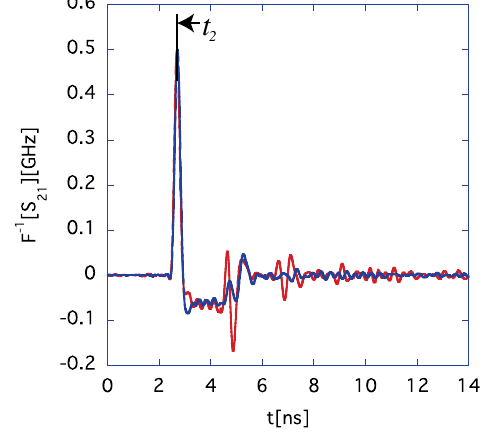
FIG. 22. Inverse Fourier transformed S 21 for the triangle electrode with (blue) and without (red) apron.